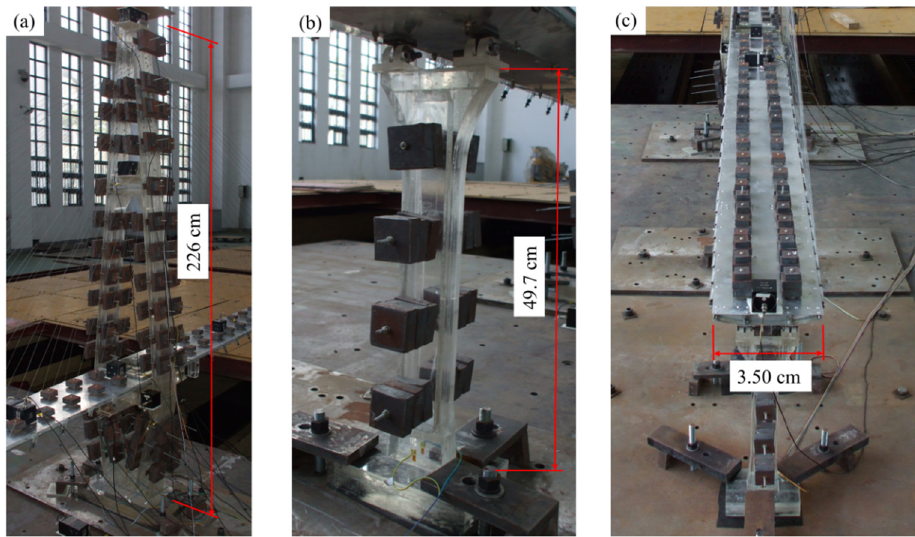
Figure 6. Arrangement of steel blocks for ( a ) tower; ( b ) pier and ( c ) girder.